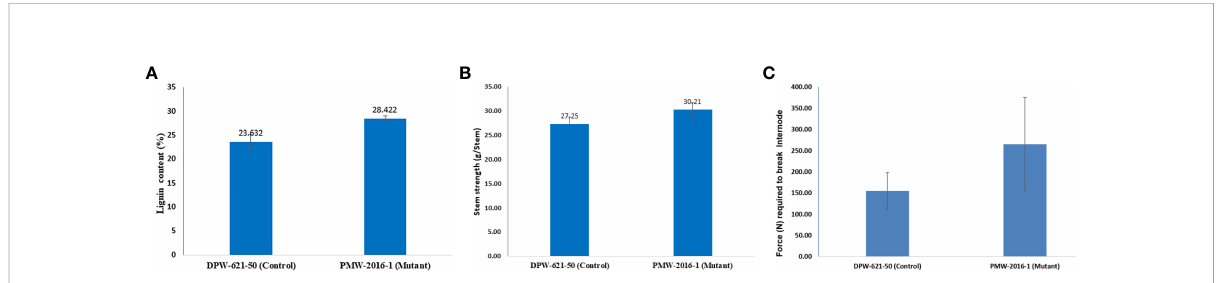
FIGURE 3 Results of (A) Lignin content (B) stem strength (C) bending stress, of 2 nd internodes of lodging tolerant mutant (PMW-2016-1) and parent (DPW- 621-50) wheat